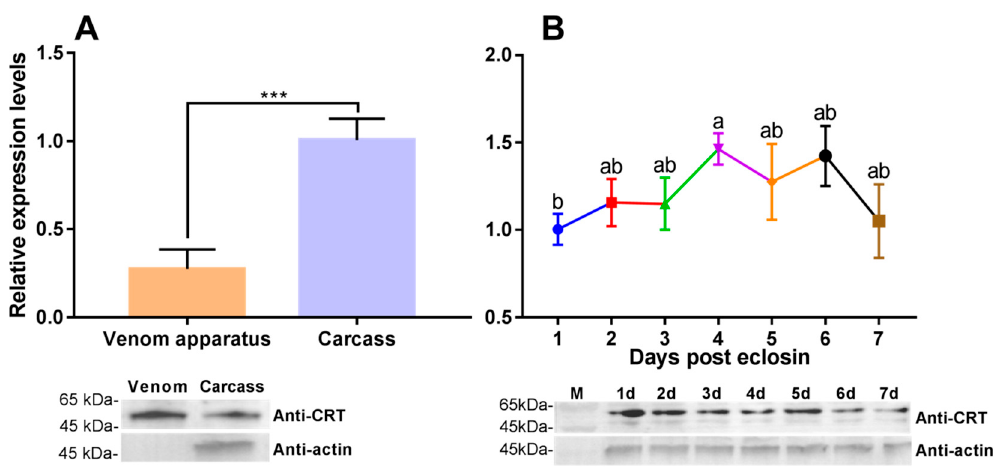
Figure 4. Expression of PvCRT in different tissues and developmental stages. ( A ) Protein expression profiles of PvCRT in venom apparatus ( n ≥ 200) and carcass ( n = 10). ( B ) Relative mRNA levels in female wasps of PvCRT at 1–7 days after emergence ( n = 10). All values in the figure are represented as mean ± standard deviation. Significant differences are labeled above the bars (unpaired two-tailed Student’s t Test, ***: p < 0.001) or different letters (one-way ANOVA followed by Tukey’s multiple comparison test, p < 0.05).